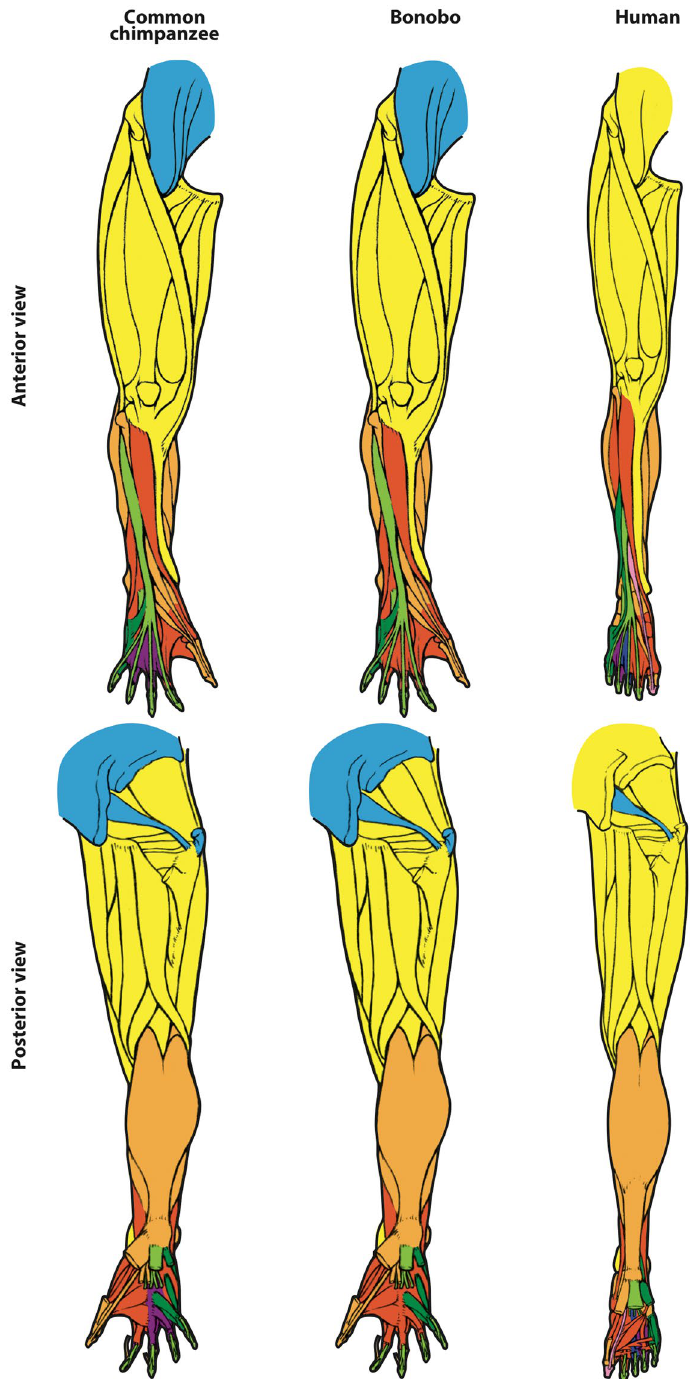
Figure 2. Hindlimb anatomical network modules of common chimpanzees, bonobos and humans. While in bonobos there is a single module related specifically to the movements of digits (dark green: of digit 5) and in common chimpanzees there are only two (dark green: of digit 5; magenta: of digits 3–4) in humans there are four, including one (pink) exclusively for the movement of the distal phalanx of the big toe (the other three are magenta: of digit 4; dark blue: of digit 3; dark green: of digit 5). For more details and for names and specific composition of each module, see text and SI1; for a list of all musculoskeletal structures and their connections, see